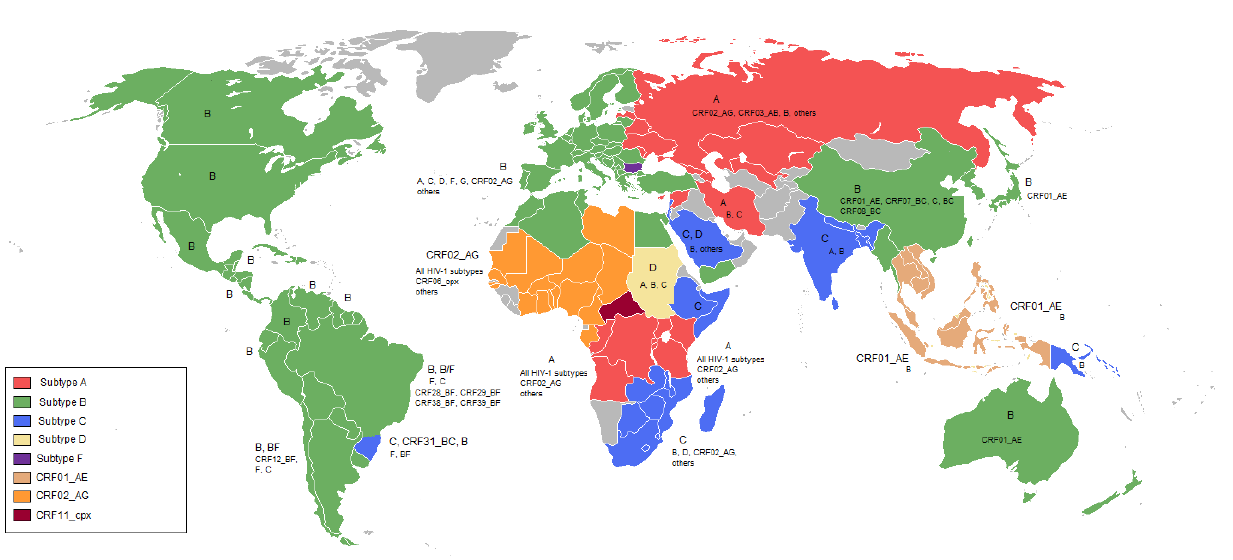
Figure 2. Worldwide prevalence of HIV-1 group M subtypes and